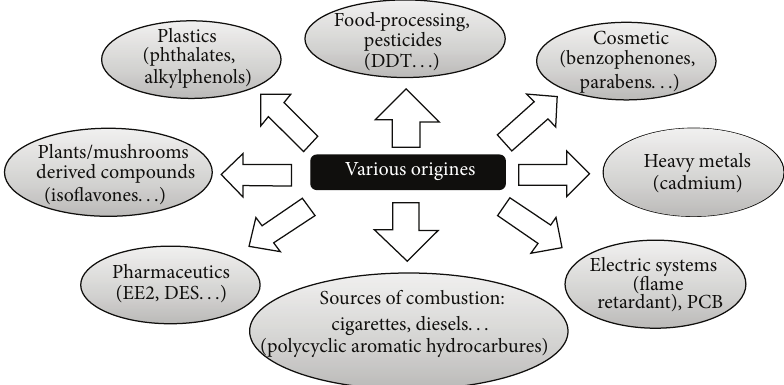
Figure 1: Sources of exposure to xenoestrogens. Various natural or synthetic molecules that enter in contact with humans by alimentation or during professional activities can interfere with estrogenic signaling pathways, explaining the great diversity of origins of the so-called xenoestrogens, illustrated